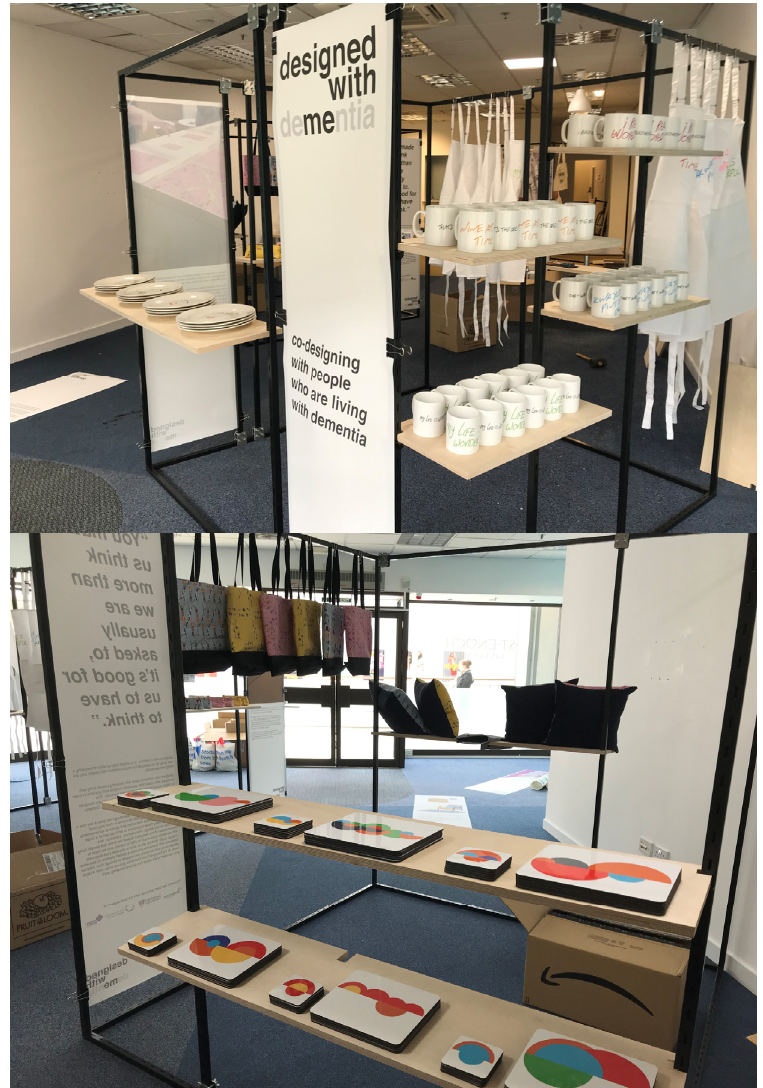
Figure 5. Designed with Dementia pop-up shop in Glasgow